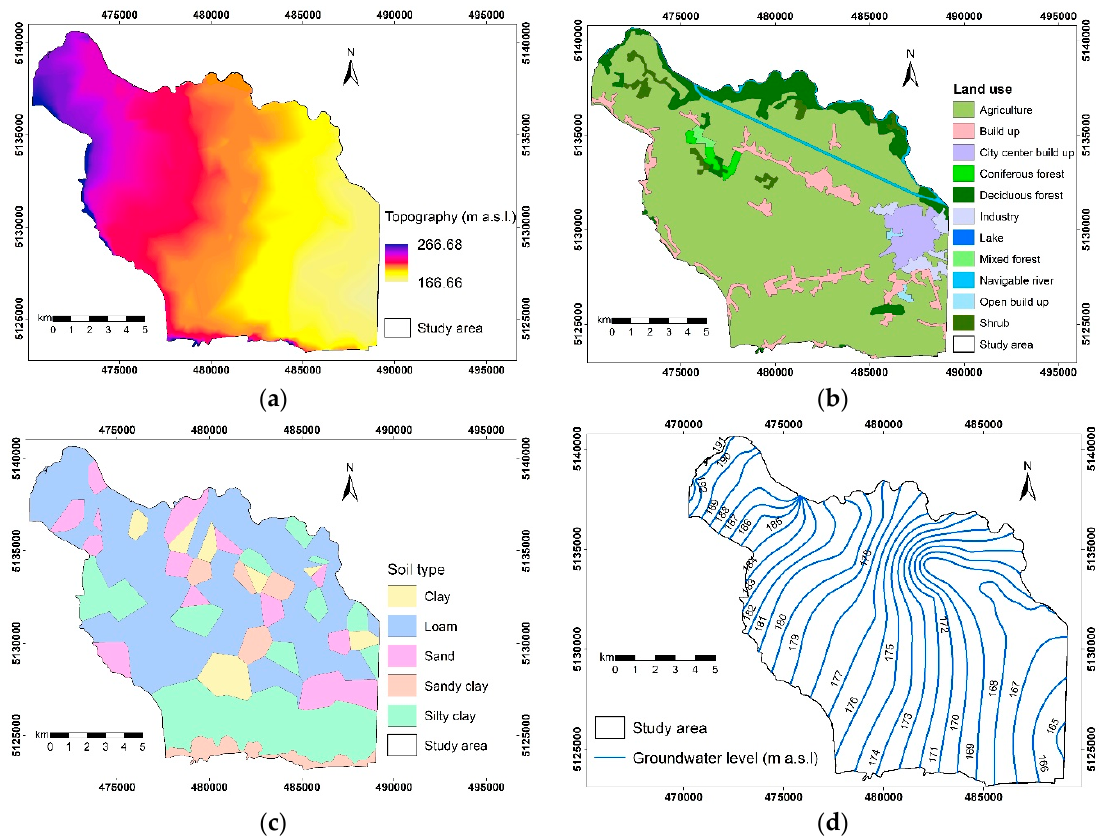
Figure 3. Input data for the Wetspass-M model ( a ) topography; ( b ) land use map; ( c ) soil map; ( d ) spatial distribution of groundwater level.